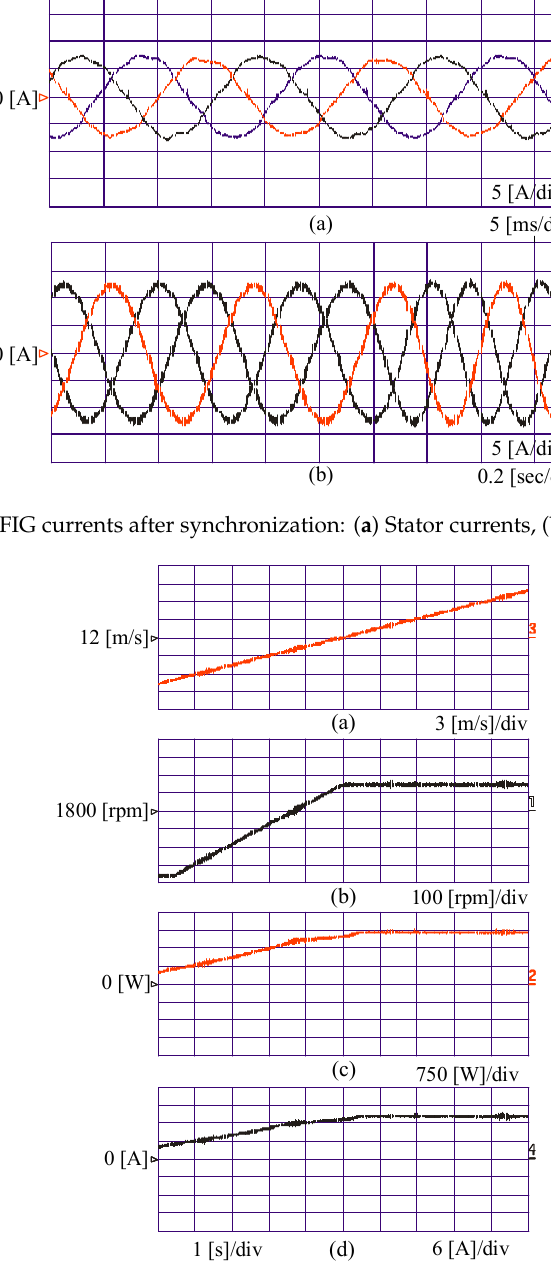
Figure 23. The simulator performance in power operation modes: ( a ) Wind speed, ( b ) generator speed, ( c ) generator power, and ( d ) q-axis current.